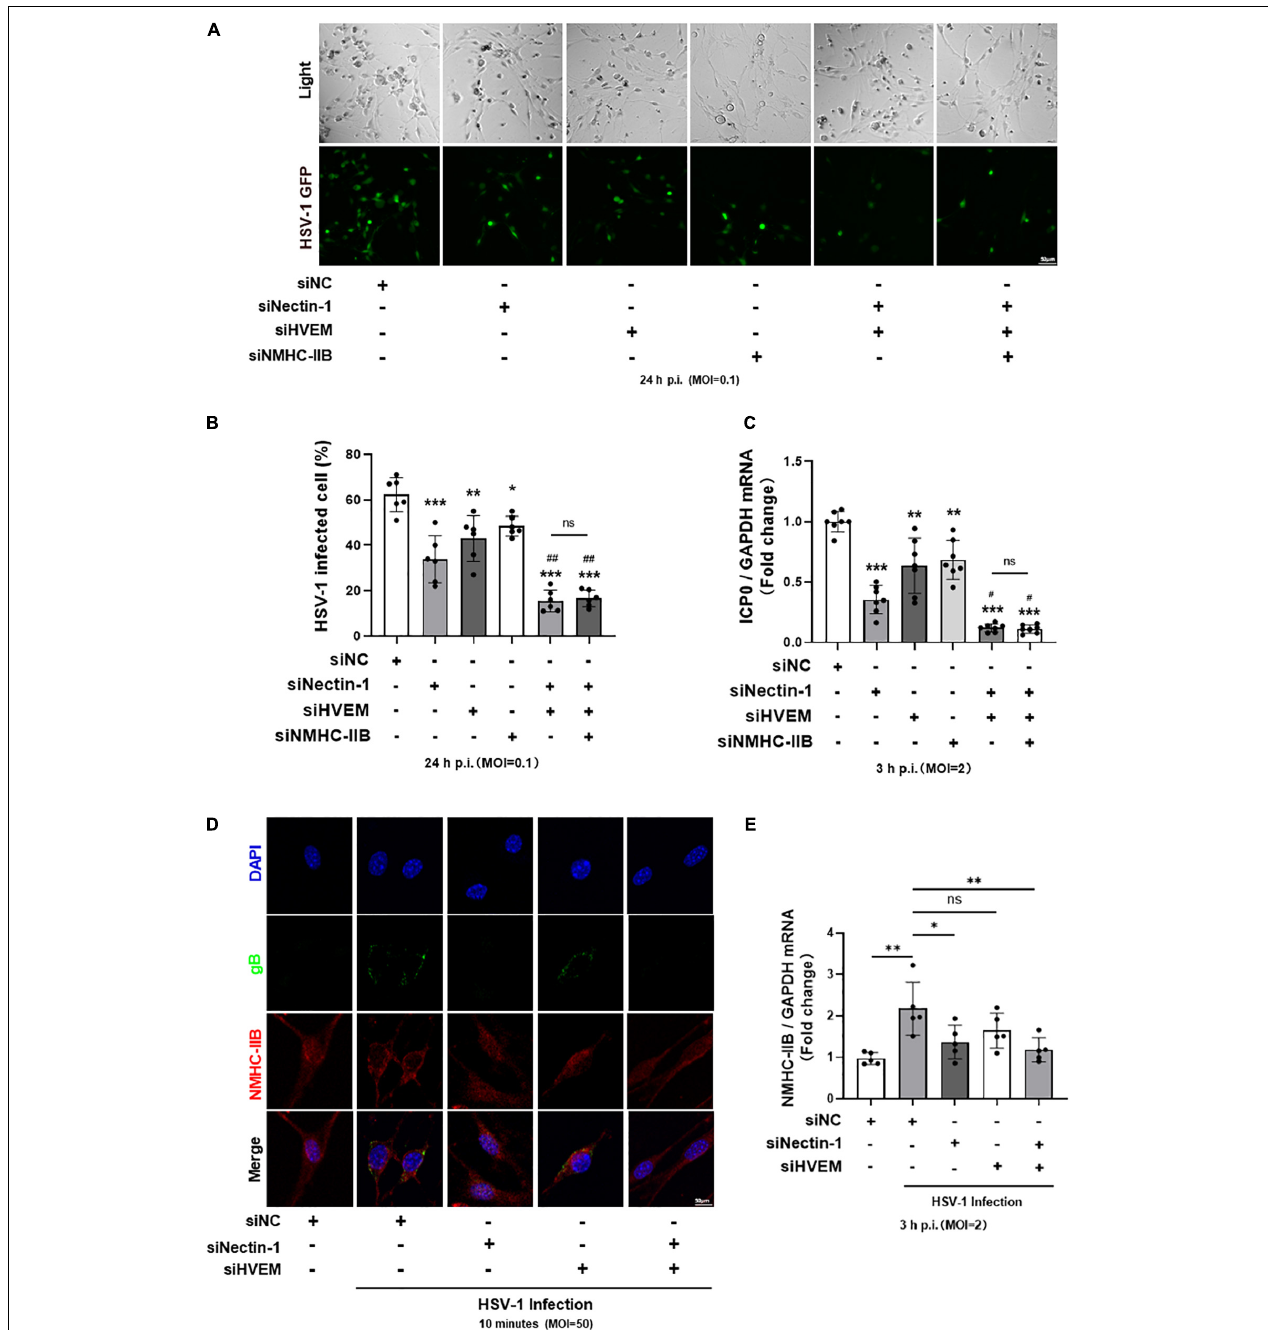
FIGURE 5 | The re-localization and increased expression of NMHC-IIB in the early stage of HSV-1 infection were inhibited by gD receptor nectin-1 knockdown. (A–C) Cultured TG neurons were transfected with siRNA against functional HSV-1 gD/gB receptors (nectin-1, HVEM, and NMHC-IIB) alone or together. Cultured TG neurons were exposed to HSV-1 after siRNA knockdown. The percentage of HSV-1-GFP infected cells (A,B) at 24 h p.i. ( n = 6) and ICP0 mRNA levels (C) at 3 h p.i. ( n = 7) were assayed. Knockdown of HSV-1 functional receptors inhibited HSV-1 infection, respectively. In contrast, simultaneous knockdown of all three receptors showed no difference compared with simultaneous knockdown of two gD receptors (nectin-1 and HVEM). (D,E) Cultured TG neurons were transfected with siRNA against functional HSV-1 gD/gB receptors (nectin-1 and HVEM) alone or together. (D) Cultured TG neurons were exposed to HSV-1 strain McKrae at an MOI of 50 at 4 ◦ C for 1 h, followed by a temperature shift to 37 ◦ C for 10 min. Shown is immunofluorescence analysis of NMHC-IIB and gB expression and localization. HSV-1 infection increased the distribution of NMHC-IIB on the cell surface, while nectin-1 knockdown or nectin-1/HVEM co-knockdown prevented this alteration. (E) Cultured TG neurons were exposed to HSV-1 and NMHC-IIB mRNA levels at 3 h p.i. ( n = 5) were assayed. HSV-1 infection upregulated the NMHC-IIB mRNA levels, while nectin-1 knockdown or nectin-1/HVEM co-knockdown prevented this upregulation. Bars denote SD. Ns, not significant, * P < 0.05, ** P < 0.01, and *** P < 0.001 vs. Ctrl or siNC. # P < 0.05, ## P < 0.01 vs. sinectin-1 pretreatment